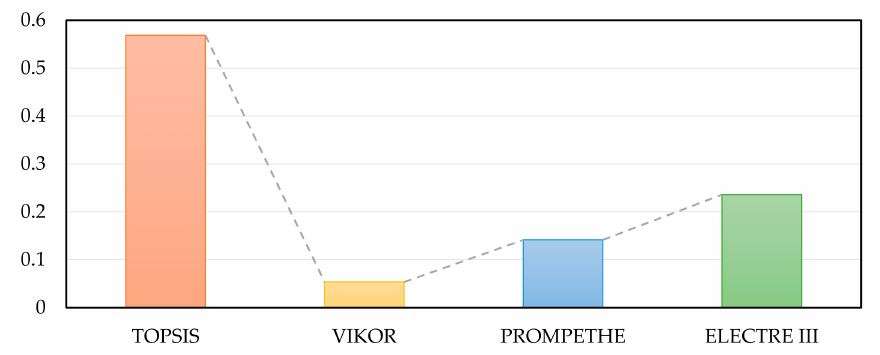
Figure 6. Weights of each method obtained by